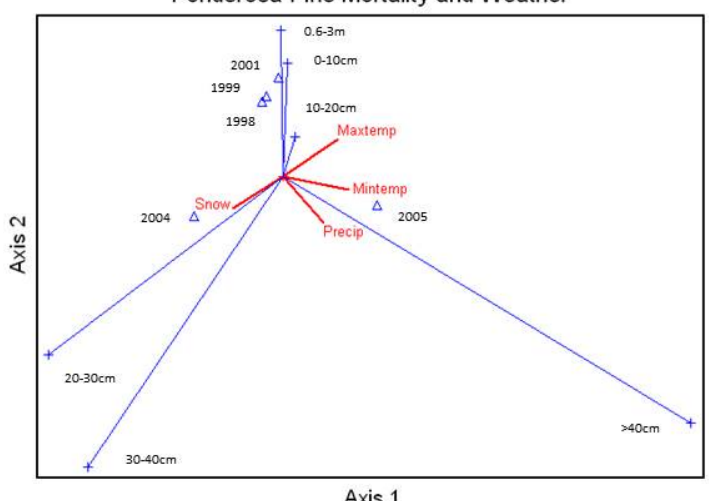
Figure 6. Canonical Correspondence Analysis Ordination for average percent mortality of the different ponderosa pine size classes by year and correlated with the calendar year snow and rainfall and average daily maximum and minimum temperatures. Snow = Snow accumulation, Cooling = lower temperatures, Heating = warmer temperatures, Precip = precipitation amounts. xx ‐ xxm = height class, xx ‐ xxcm = diameter class.